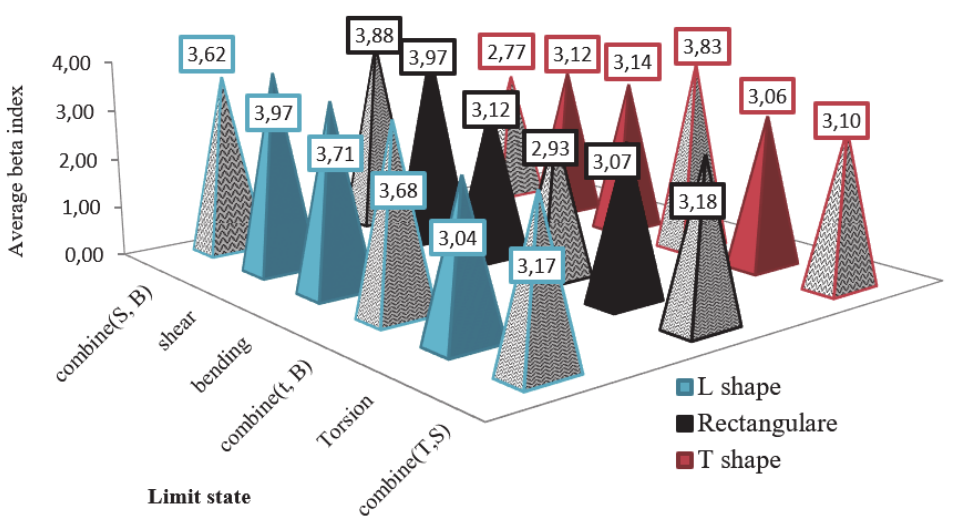
Figure 11: Average ACI beta indexes for different cross-sections.